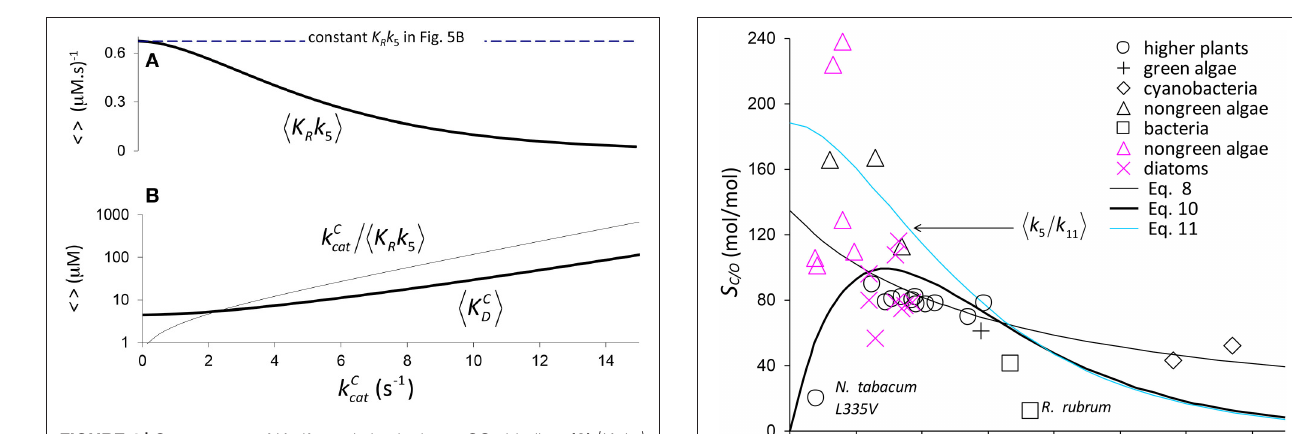
that is also conditional on k C Figure 4A